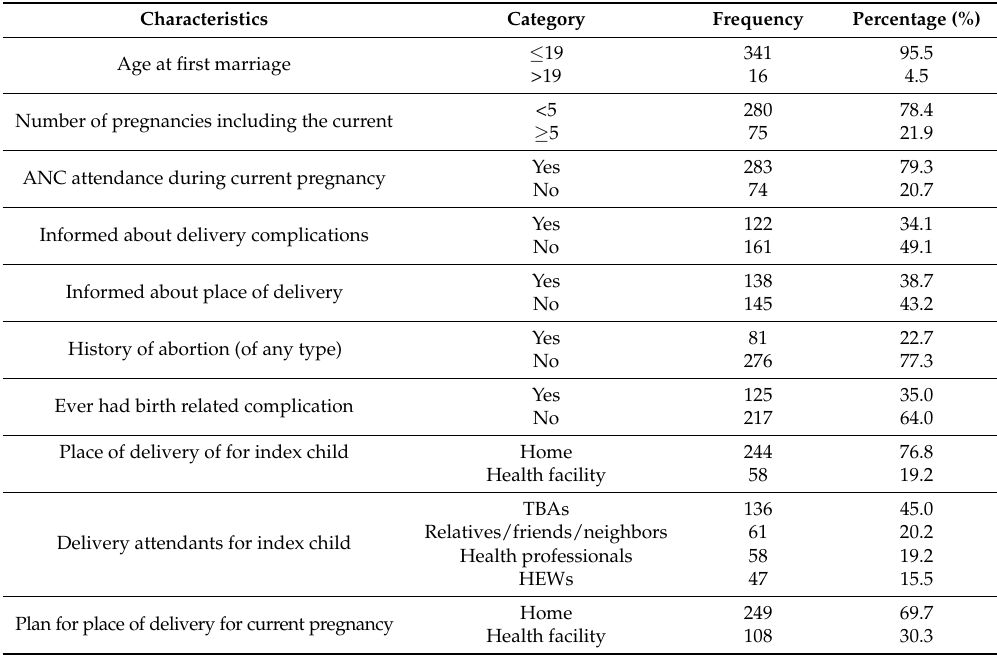
Table 2. Pregnant women’s obstetric characteristics in Gabi-Rasu zone of Afar region, Ethiopia, 2016 ( n =